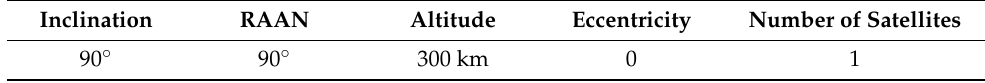
Table 1. Orbital elements of the satellite. Table 2. Specifications of the star sensor.